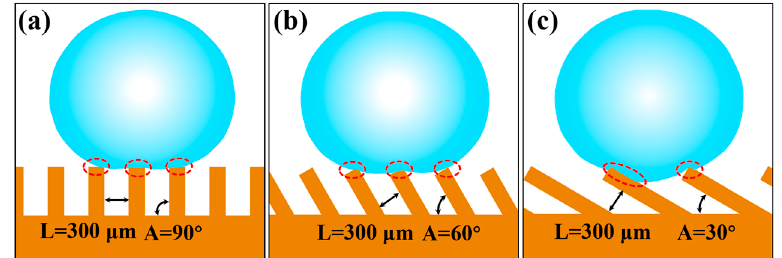
Figure 10. Schematic diagram of water droplets on different inclined groove ( L = 300 µm) structures: ( a ) A = 90°; ( b ) A = 60°; ( c ) A = 30°.